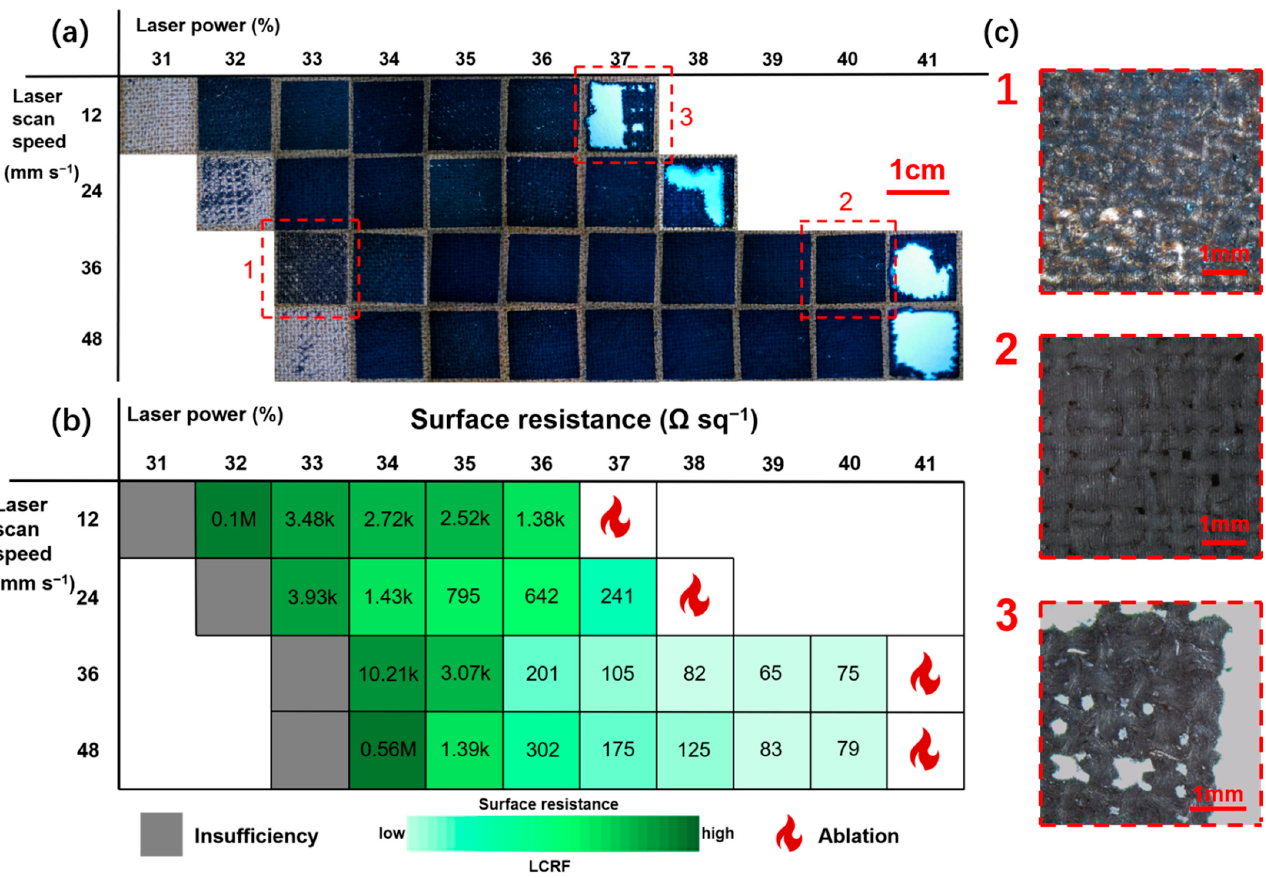
Figure 2. ( a ) LCRF engraved by different laser scan speed and power and ( b ) their surface resistance. ( c ) different LCRF for three different laser scan speeds and power.